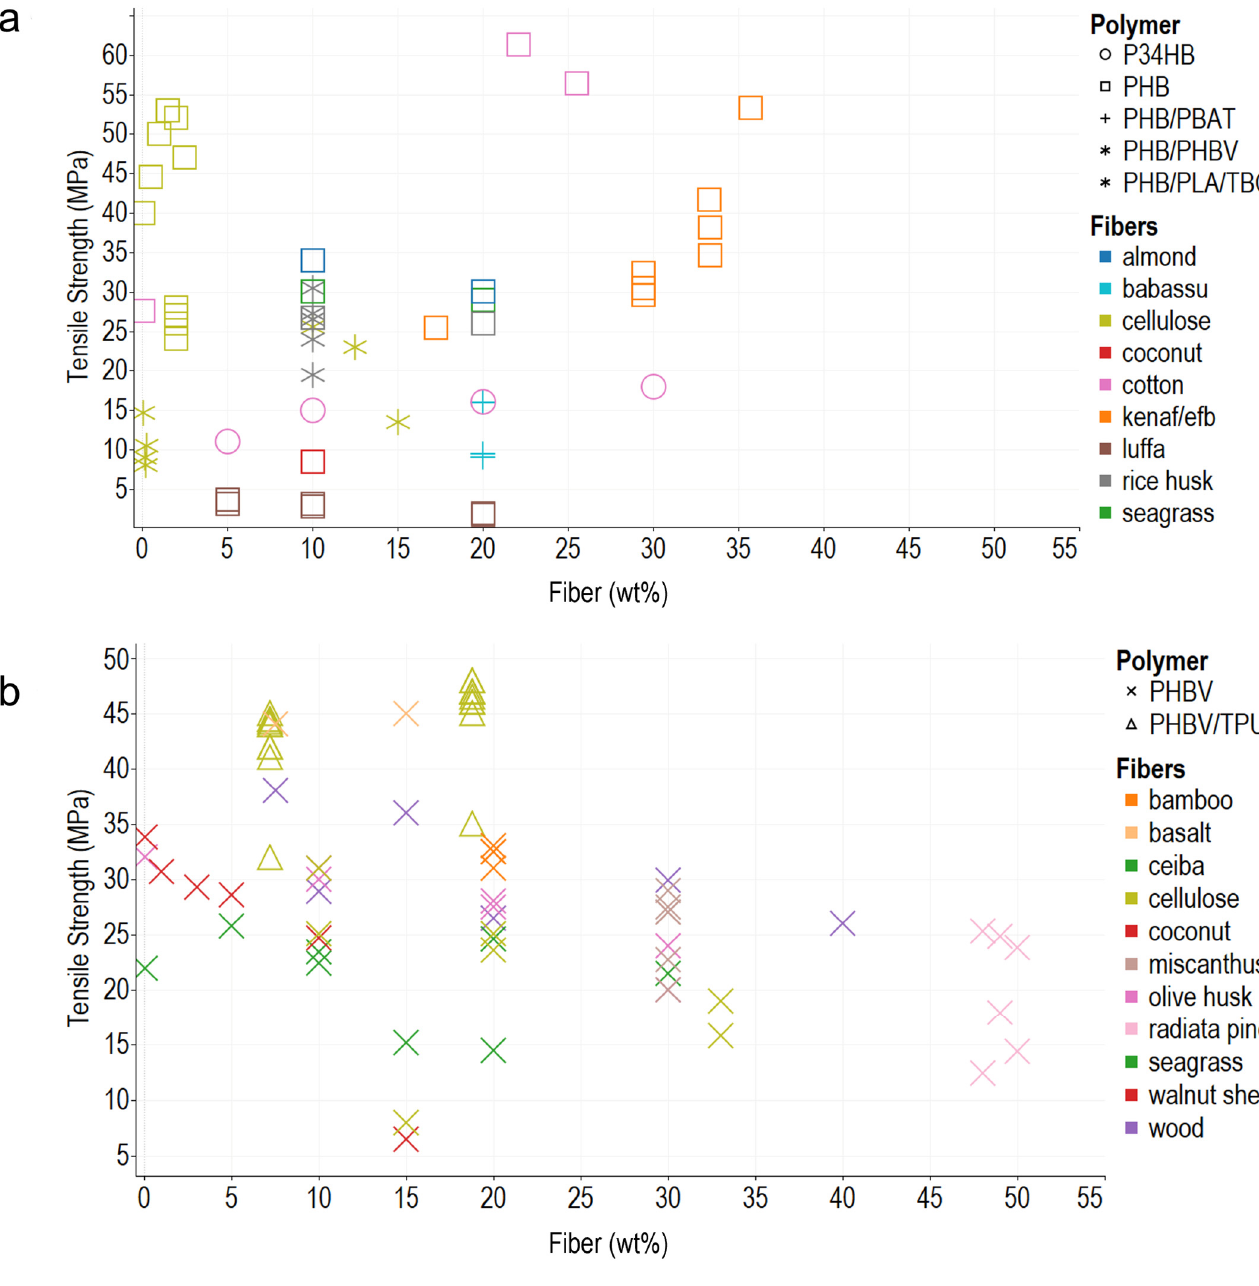
Figure 2. Tensile strength. ( a ) PHB and PHB/PBAT blends. ( b ) PHBV and its blends with PBAT and TPU. The colors refer to the fiber type (fillers), and the shapes refer to polymer types (matrix).